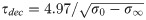
DMFT for the inhibitory rate model with g(x) = ϕ(x), I
0 = 1.A: The PAC amplitude, σ
0 − σ
∞, is plotted against J
0. At fixed point σ
0 − σ
∞ = 0 (blue). When J
0 = J
c ≈ 4.995 (black dot, BP) the chaotic state appears. For J
0 > J
c, the fixed point is unstable (dashed blue) and the network settles in the chaotic state (σ
0 − σ
∞ > 0, black). Red: Perturbative solution in the limit J
0 → J
c (see S2 Text). Inset: σ
0 − σ
∞ vanishes linearly when δ = J
0 − J
c → 0+. Black: Numerical solution of the DMFT equations. Red: Perturbative solution at the leading order, O(δ). B: (σ − σ
∞)/δ is plotted for different values of δ > 0 showing the convergence to the asymptotic form (Eq (11) in S2 Text) in the limit δ → 0. C: Blue dots: Decorrelation time, τ
dec vs. PAC amplitude. The PAC, σ(τ) − σ
∞, was obtained by solving numerically the DMFT equations and τ
dec was estimated by fitting the result to the function A/cosh
2(τ/τ
dec). Red: In the whole range, J
0 ∈ [5, 7] considered, τ
dec can be well approximated by τdec=4.97/σ0−σ∞. This relation becomes exact in the limit σ
0 − σ
∞ → 0. Inset: Numerical solution of the DMFT equations for J
0 = 6.65 (blue dots) and the fit to A/cosh
2(τ/τ
dec) (red). The fit is very good although this is far from bifurcation.